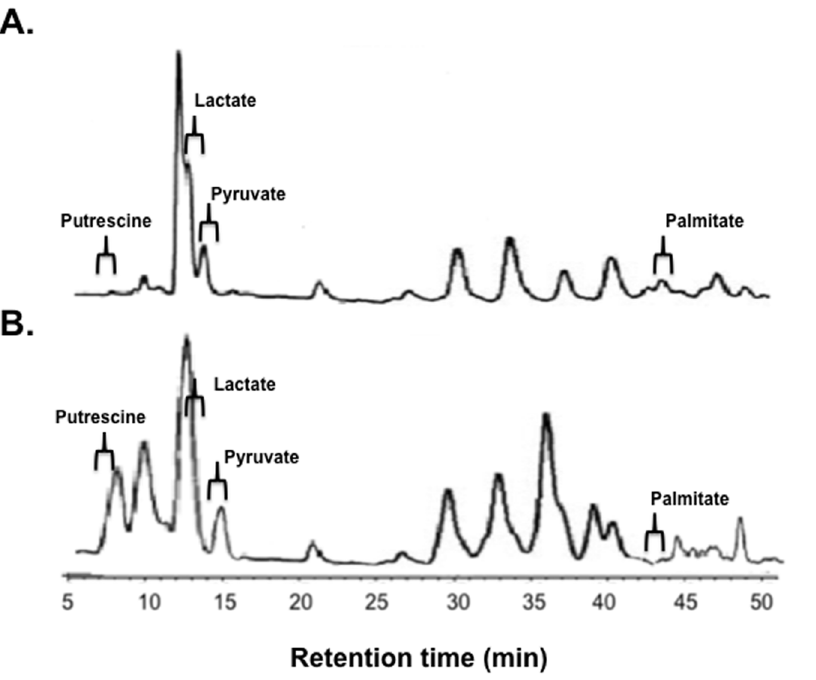
Figure 5. Representative HPLC trace of metabolites from sputum taken from a CF patient during a period of stability (A) and presenting with pulmonary exacerbation (B). Regions are labelled to indicate a range were metabolites of interest that were recovered from samples. Specific concentrations of metabolites identified are detailed in Tables S4 and S5.